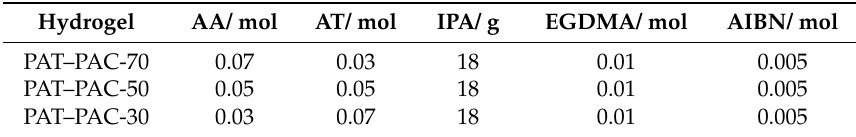
Table 6. Hydrogel